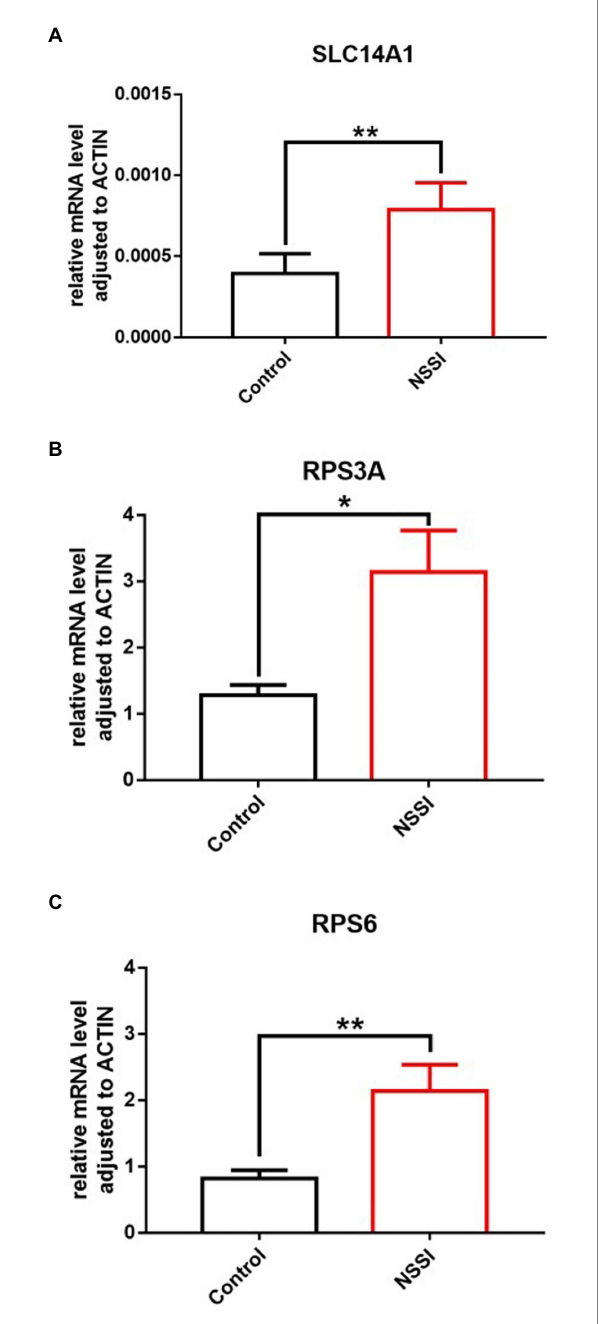
FIGURE 4 Expression levels of SLC14A1 / RPS6 / RPS3A in peripheral blood of NSSI patient group and healthy control group: (A) SLC14A1 , (B) RPS3A , and (C) RPS6 . * p <0.05, ** p <0.01.